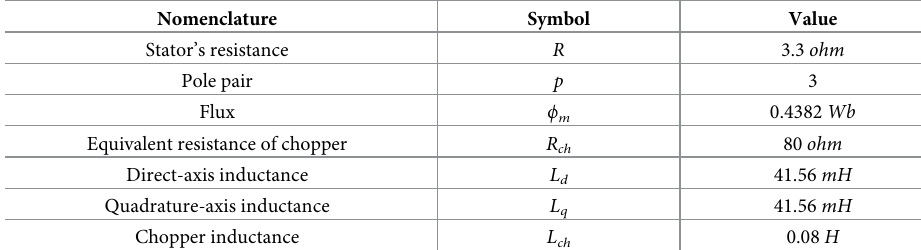
Table 3. Parameters of PMSG.